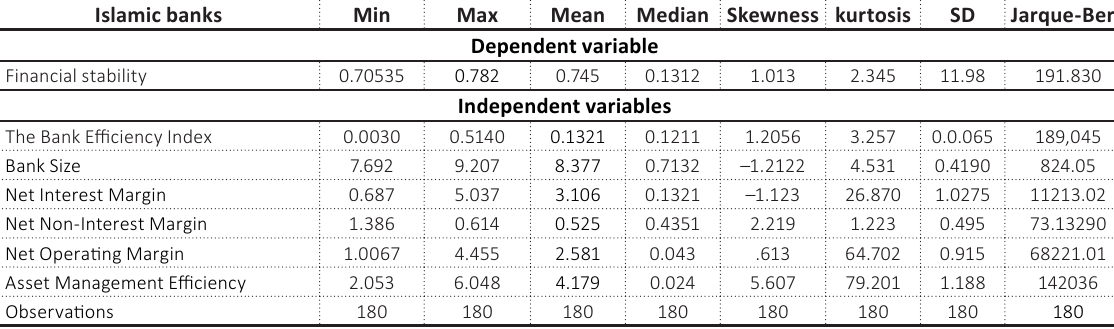
Table 9. Descriptive statistics for Model C